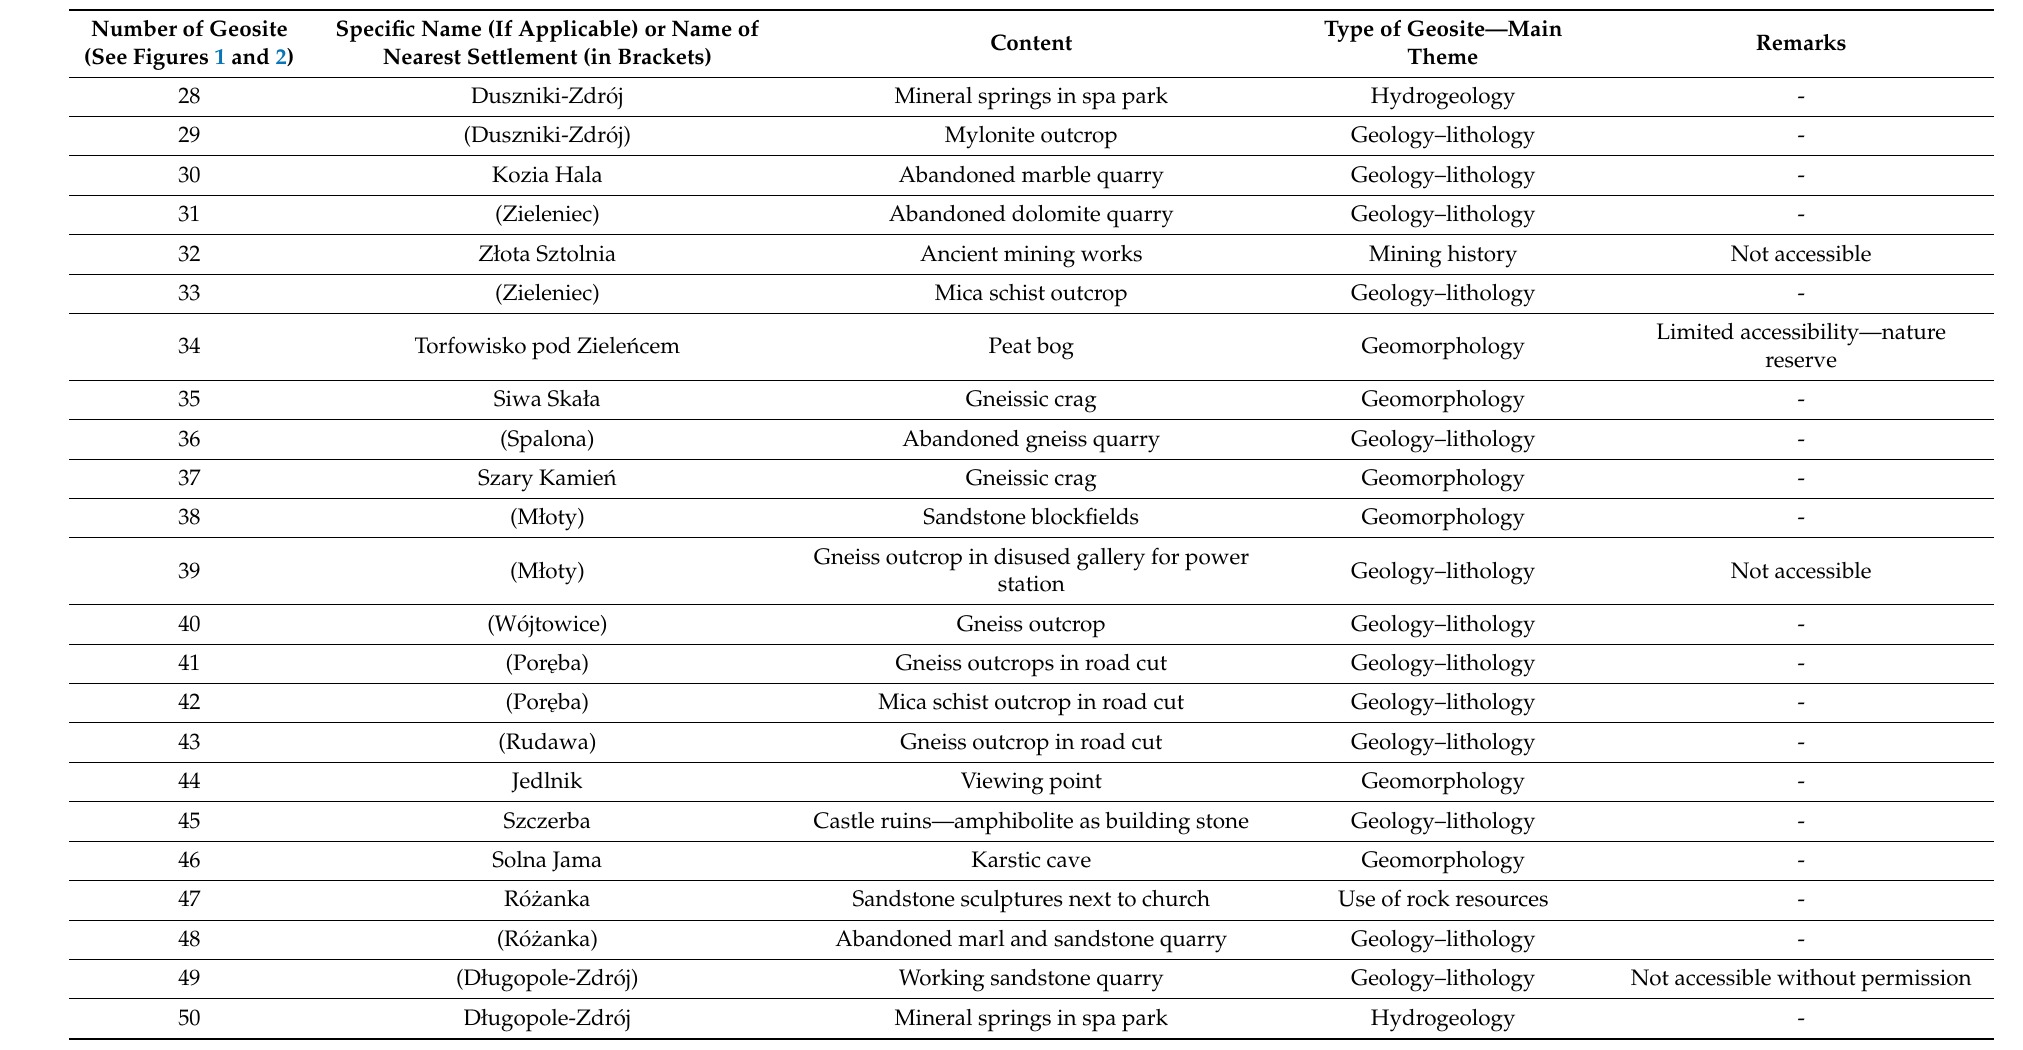
Table 2. List of geosites in the Polish part of the Orlick é –Bystrzyckie Mountains Block, included into Geostrada Sudecka project